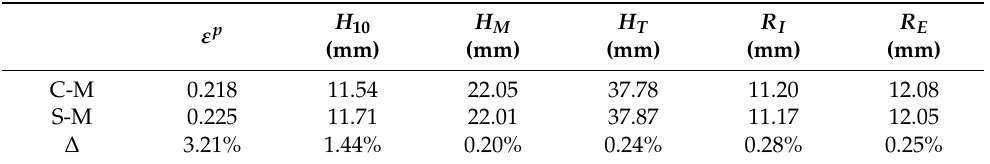
Table 5. Comparison between the complete model (C-M) and simplified model (S-M) for dynamic tensile